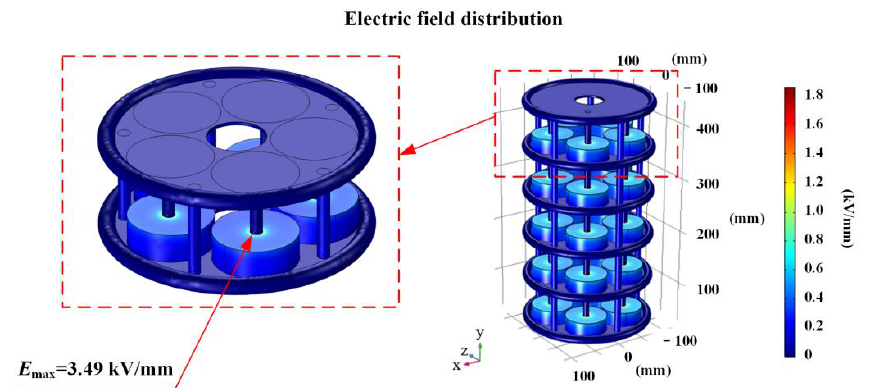
Figure 4. Electric field distribution of the unit in the high – voltage arm.